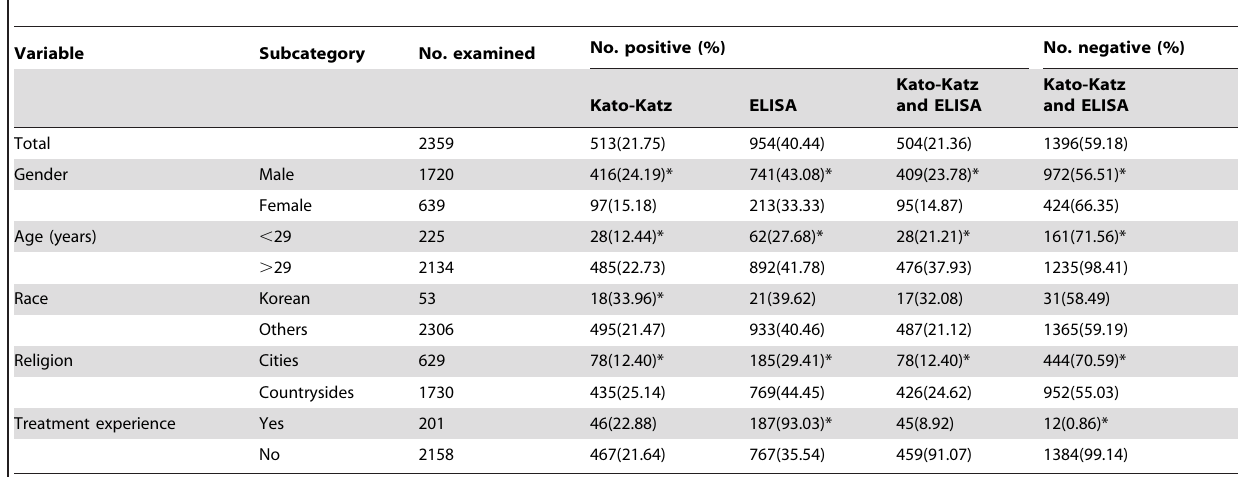
Table 5. Characteristics of Human Clonorchis sinensis infection in Heilongjiang Province detected by Kato-Katz and ELISA examinations.